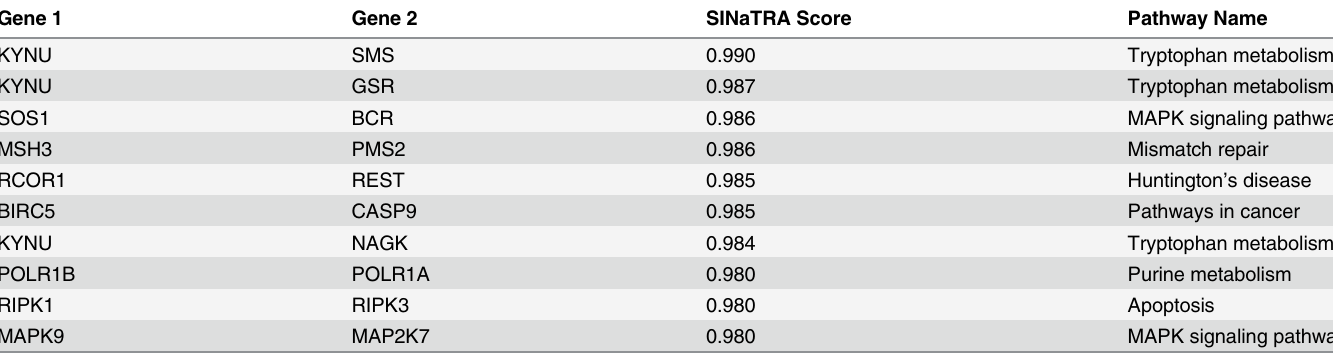
Table 3. The top ten highest scoring within-pathway, putative SL gene